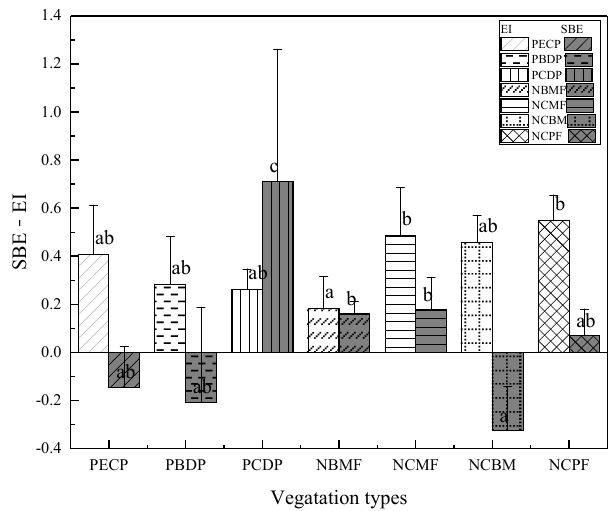
Figure 5. SBE and ecological integrity. Different lowercase letters (a, b, ab, c) in the figure indicate significant differences in SBE of different vegetation types ( p < 0.05 )